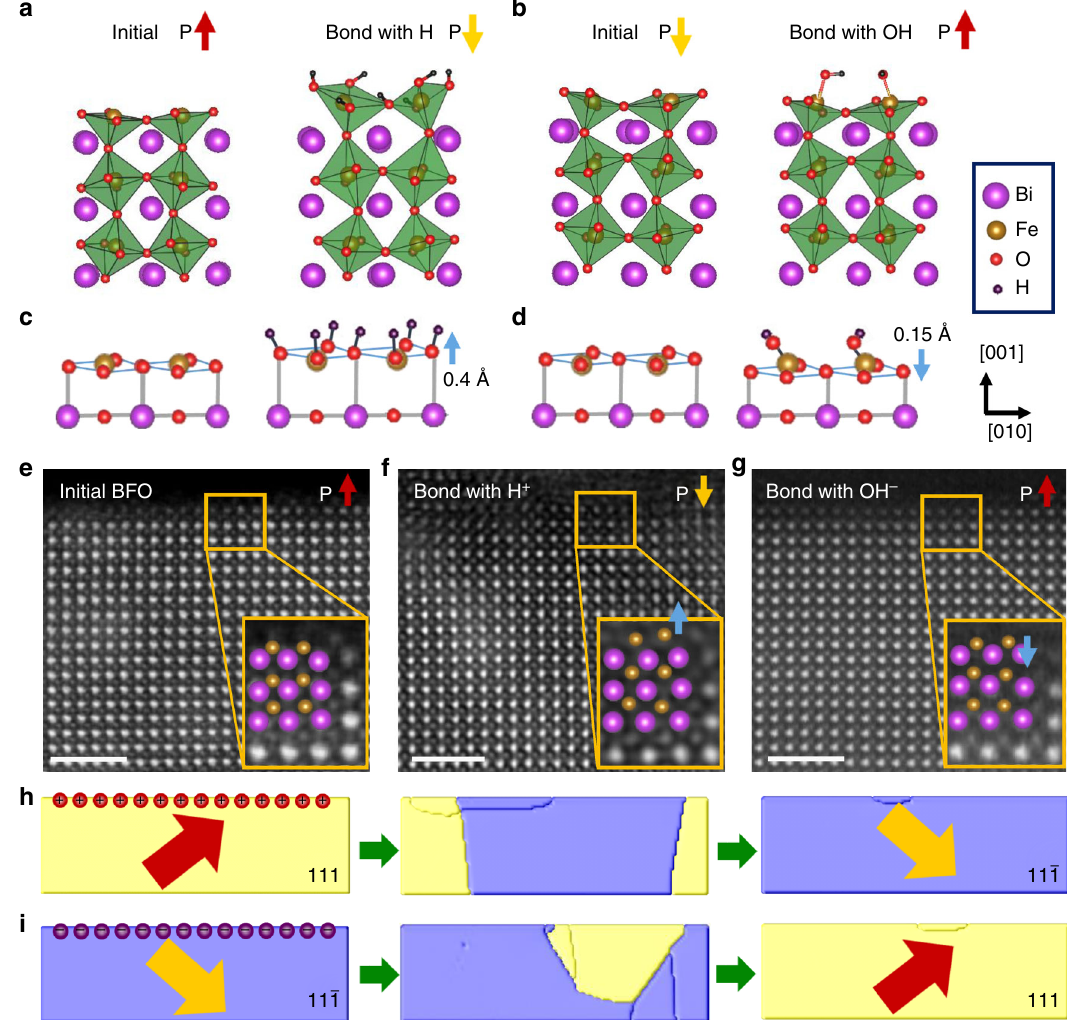
Fig. 4 Chemical-bonding-induced switching of ferroelectric polarization. BFO polarizations are switched from upward/downward to downward/upward with adsorbed of four H ( a ) and two OH ( b ), respectively. BFO surface Fe and O atomic displacements along z -axis with four H ( c ) and two OH ( d ) adsorption by density function theory. Scanning transmission electron microscopy images of initial BFO thin fi lm ( e ) after contact with acidic-solution ( f ) and Milli-Q water ( g ). The arrows in a , b , and e represent the out-of-plane component of the polarization. Scale bar, 2 nm ( e ). h , i Phase- fi eld simulations of bulk polarization switching processes based on the emerging surface